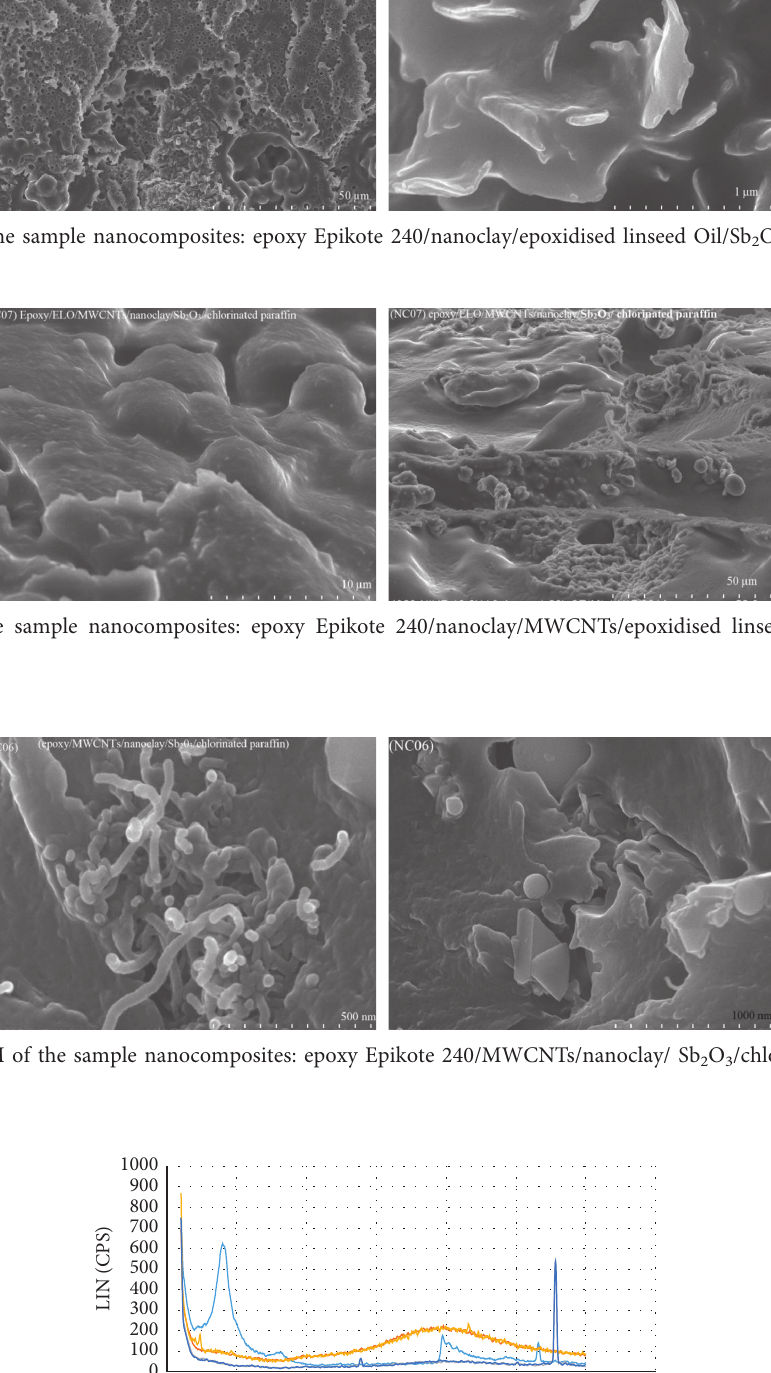
2 O 3 /chlorinated paraffin.